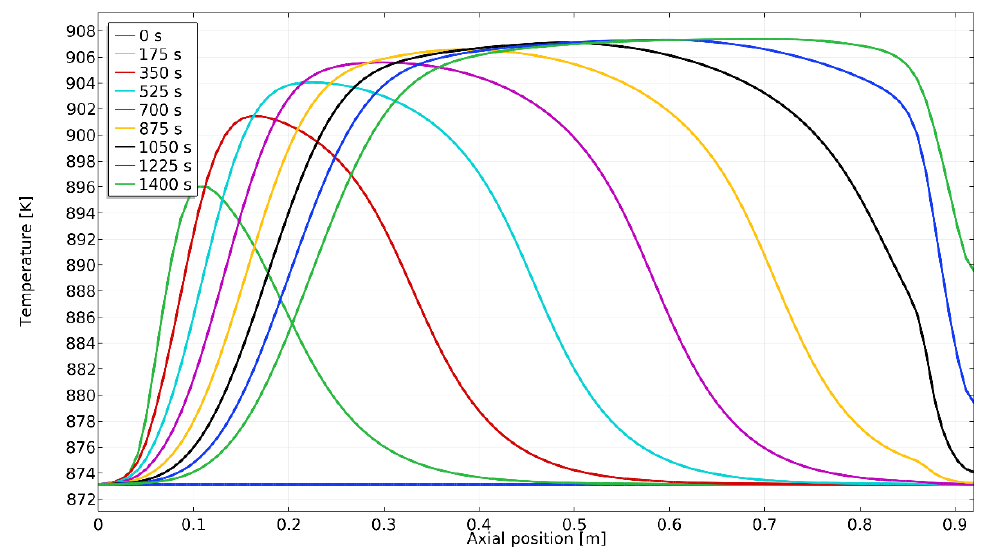
Figure 7. Model predicted axial temperature profiles during reduction with H 2 .